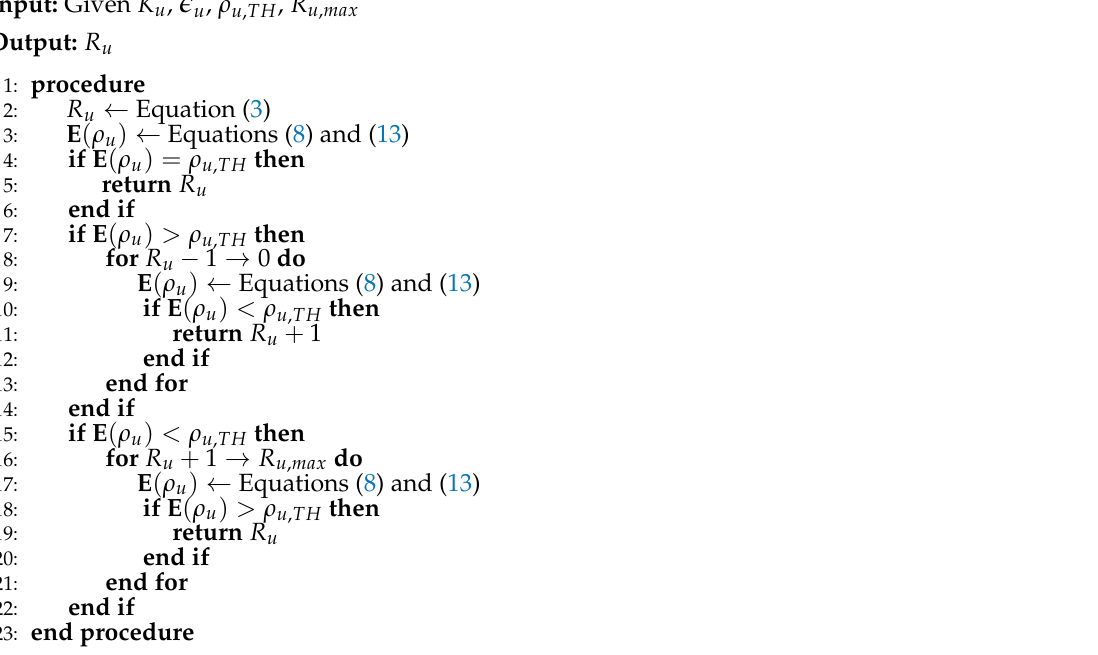
Algorithm 1 Proposed bandwidth-efficient and channel-aware error control